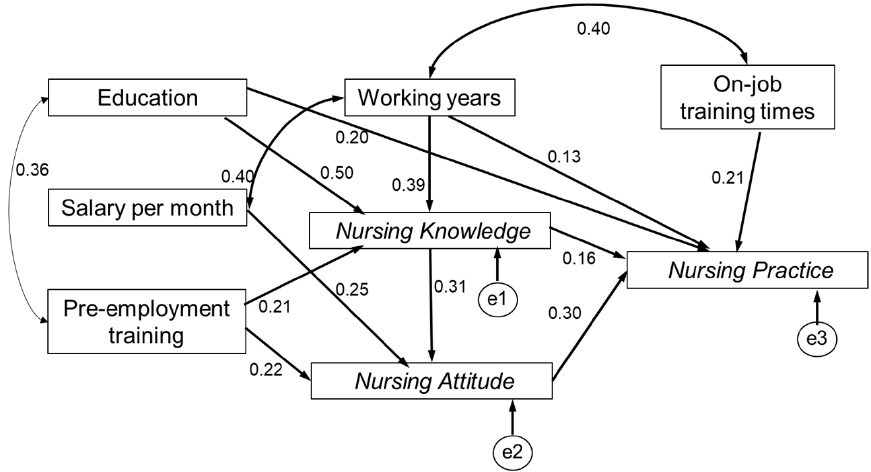
Figure 3. A structural equation model of knowledge, attitude and practice regarding elderly care.